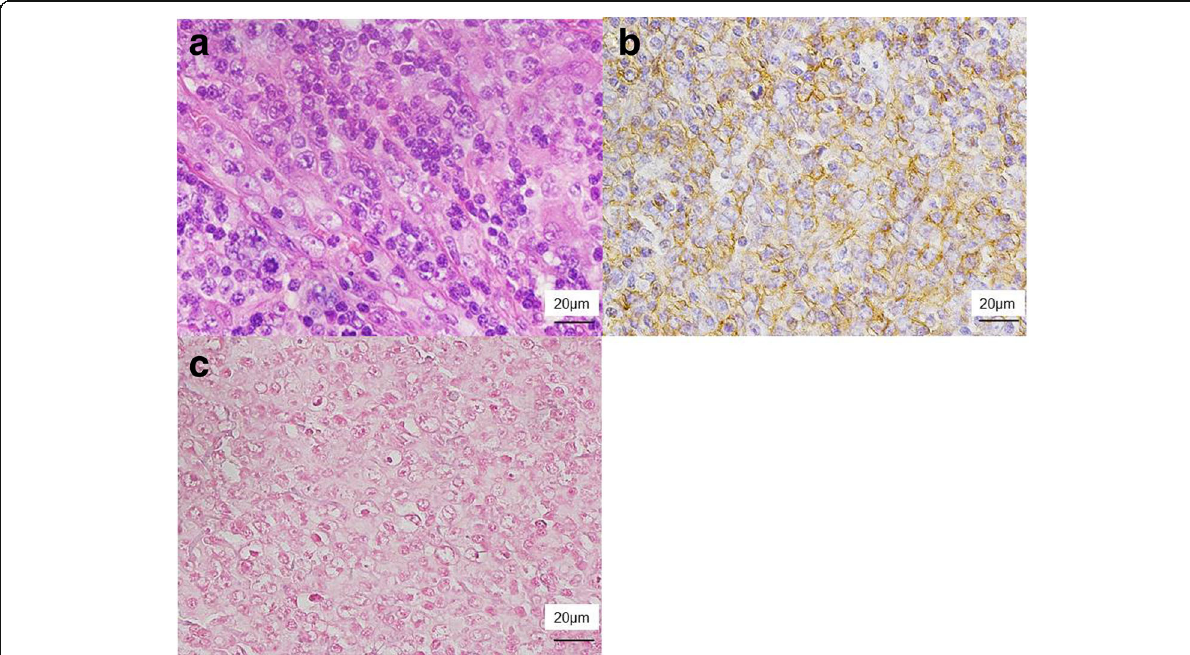
Fig. 2 Microscopic findings of biopsy from the cervical lymph node. a Hyperplasia of large and pleomorphic atypical lymphoid cells was observed in the lymph nodes (hematoxylin/eosin). b Immunohistochemical staining was positive for CD20. c Epstein – Barr virus-encoded ribonucleic acid in situ hybridization was negative in the tumor cells